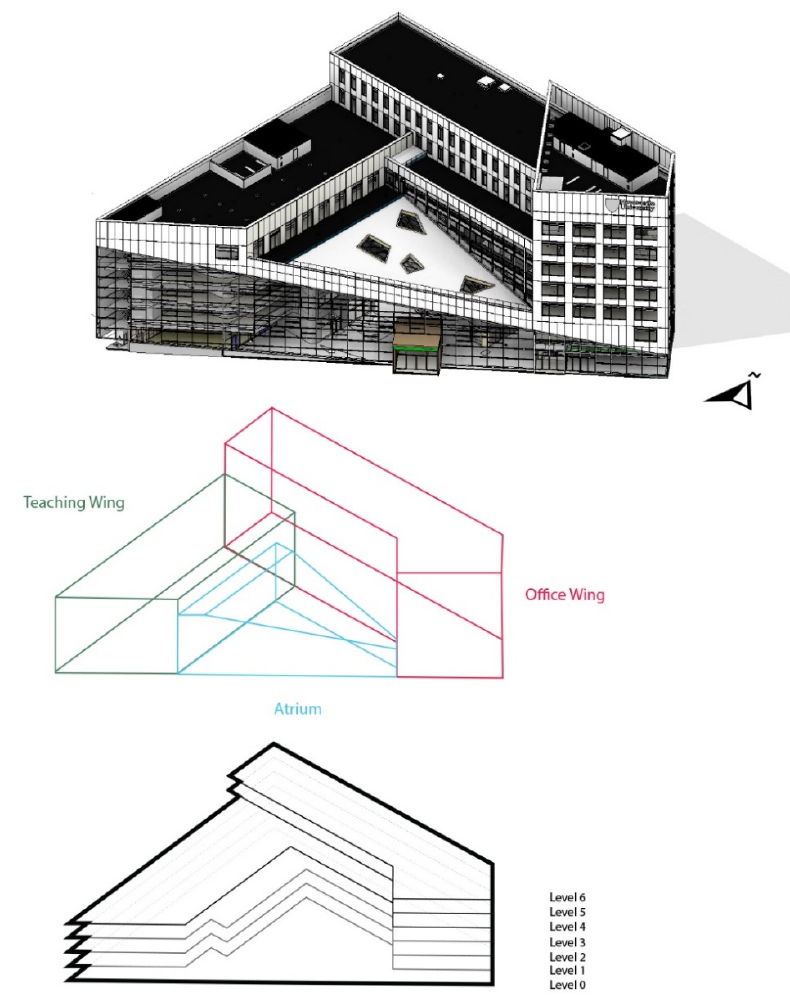
Figure 1. Urban Science Building (USB).